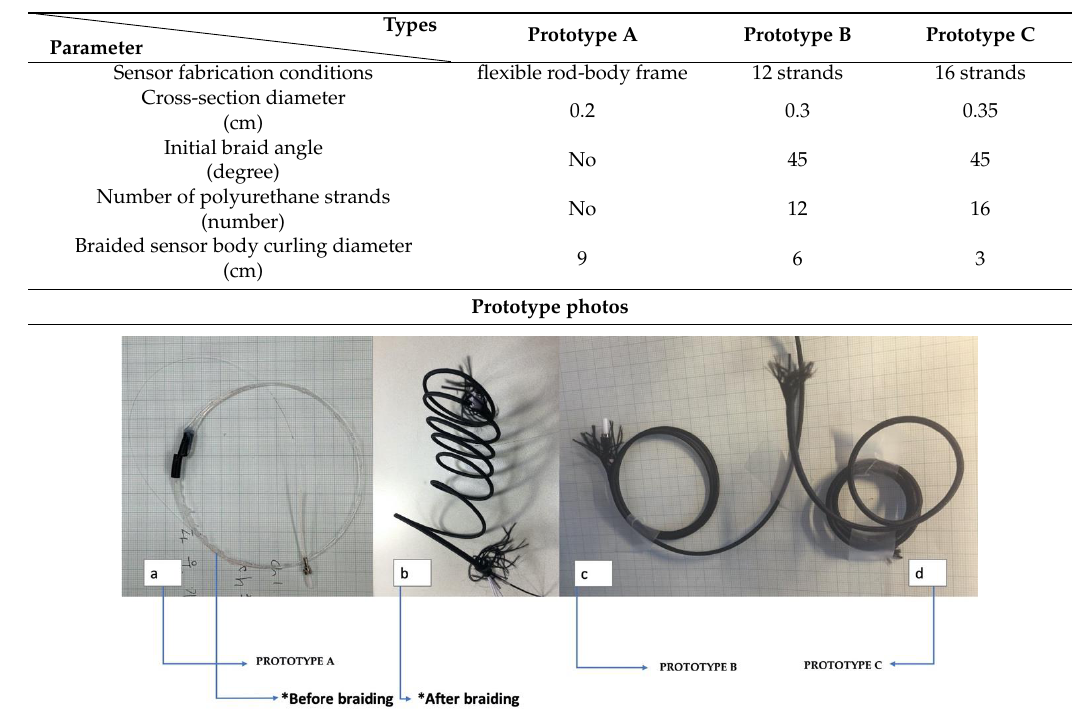
Table 1. The states of the sensor before and after the braid. Table 1c, d show the cases where 1 strand of polyurethane is braided, and 16 strands of polyurethane are braided. The diameter of the cross-section of the sensor and the diameter of the helical size are indicated.